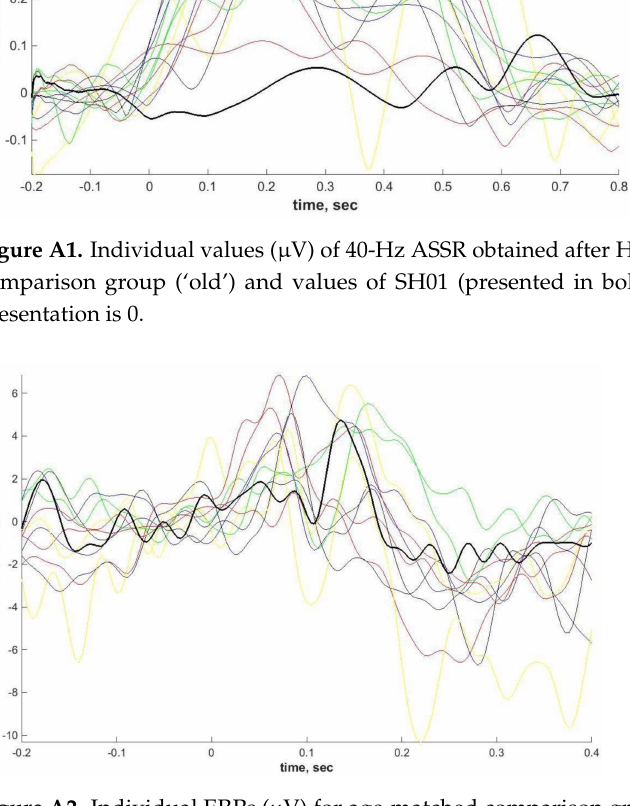
Figure A2. Individual ERPs ( µ V) for age-matched comparison group (‘old’) and SH01 (cid:48) s ERP (pre- sented in bold